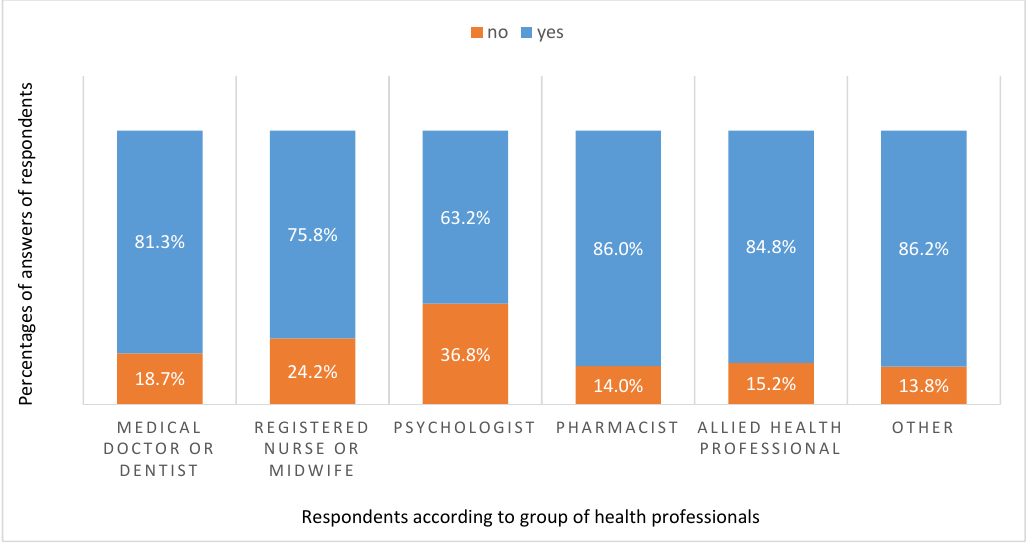
Figure 2. Knowledge of the correct definition of probiotics among different health profession groups. Blue proportions show the percentage of health professionals that chose the correct definition in each group.